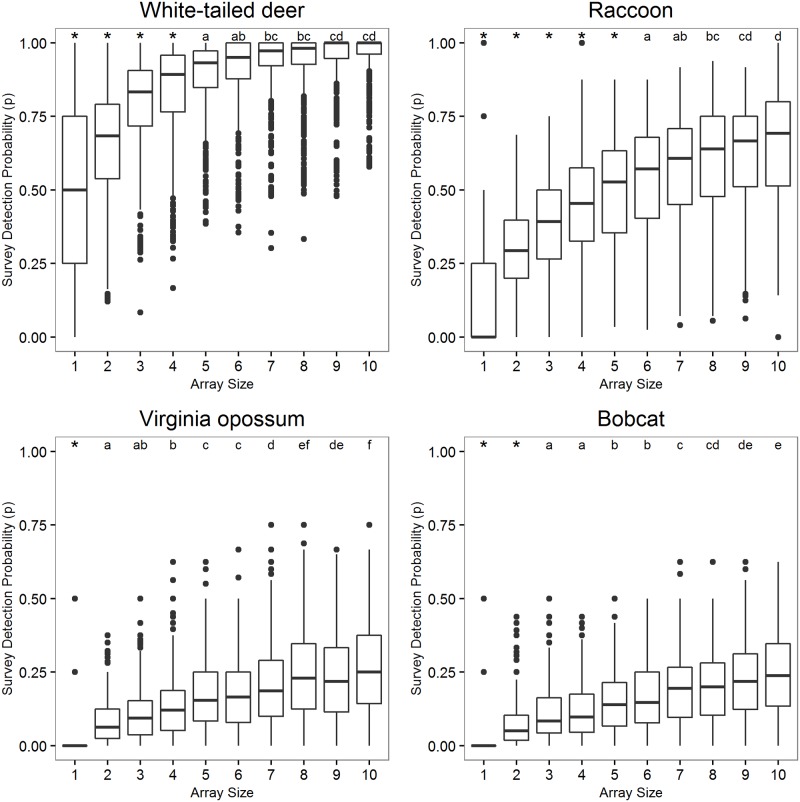
Survey detection probability (p) by array size (number of cameras; 1–10) per site across four species (White-tailed deer, upper left; Raccoon, upper right; Virginia opossum, lower left; Bobcat, lower right), calculated by randomly parsing a yearlong data set by season and replicate length with 5,000 Monte Carlo iterations.Asterisks (*) indicate significant differences and letters indicate non-significance between array sizes based on a multiple comparisons of mean survey detection probability accounting for non-normality and heteroscedasticity (p < 0.05).